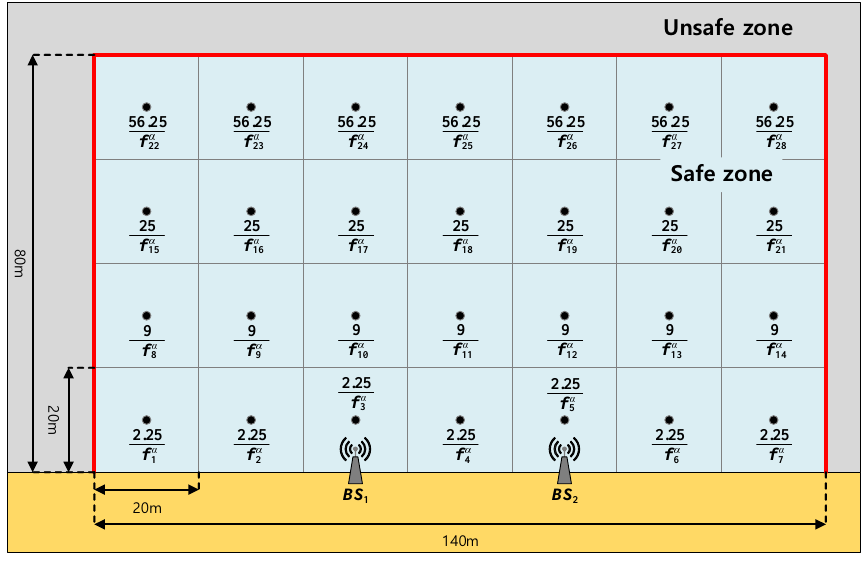
Figure 7. The risk map that represents R i ( f i ) given in